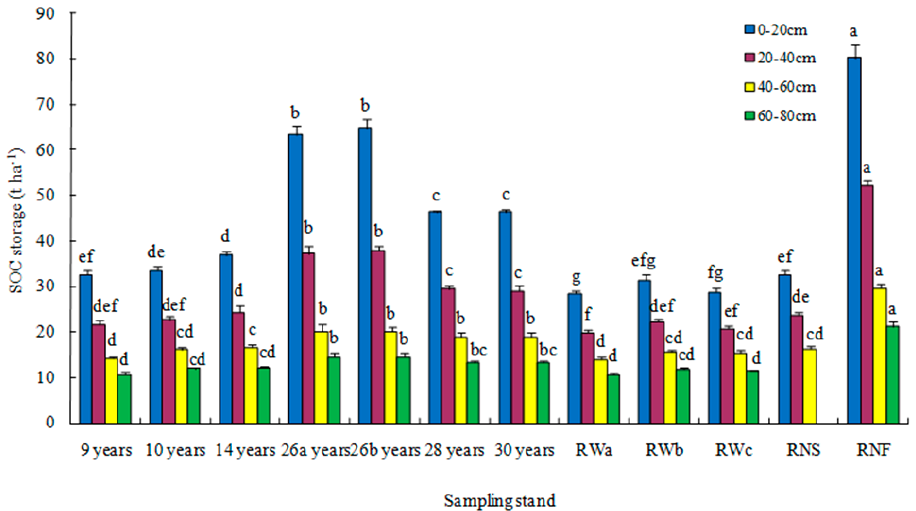
Figure 1. Soil organic carbon (SOC) storage at di ff erent depths in the soil profile of mixed plantations, reference wastelands, reference natural recovery shrub grassland (RNS), and reference natural forest (RNF) (t C ha − 1 ).